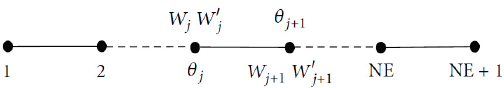
Figure 2. Discretized domain along the beam span using N elements and 3 DOF per node. The dotted line is used to show that there are more elements than shown in the figure, before and after the element at the middle.